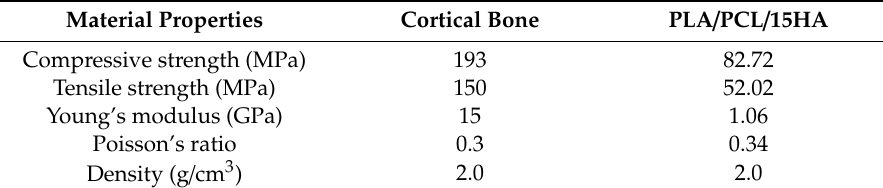
Figure 3. The FEA models with middle canine femoral shaft fractures and fixation techniques.